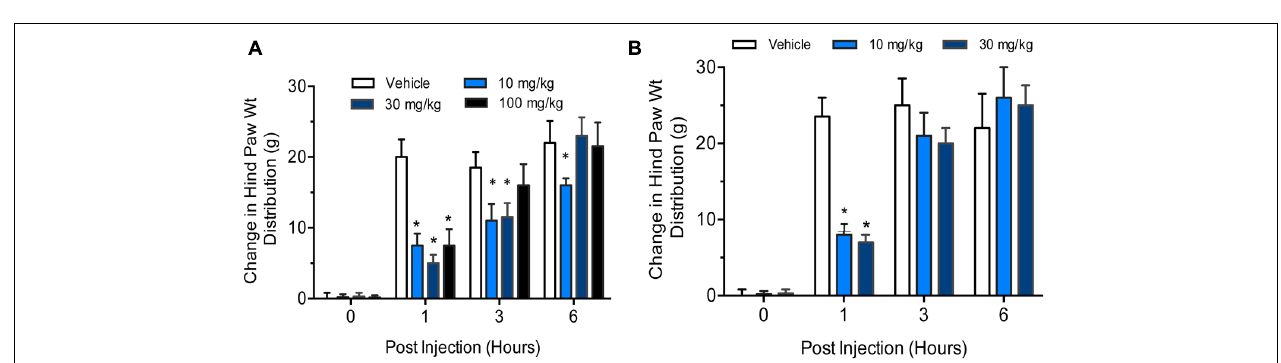
FIGURE 7 | Effect of gemcabene on change in hind paw weight distribution in the rat IL-6/IL-6sR knee injection model. (A) Experiment 1 Baseline incapacitance readings were taken on Day –1. IL-6/IL-6sR and PBS were injected on day 0. Gemcabene (10, 30, or 100 mg/kg) was given p.o. 3 h before IL-6/IL-6sR injection. Changes in hind paw weight distribution were determined 1, 3, and 6 h post-injection (4, 6, and 9 h post-gemcabene dose). Statistically significant differences were determined by one-way ANOVA followed by the Hochberg’s procedure ( ∗ p < 0.001). Data are expressed as mean ± SEM. N = 10 rats per group. (B) Experiment 2 was carried out same way as experiment 1, but at only two doses, 10 and 30 mg/kg. The results show reproducibility of the